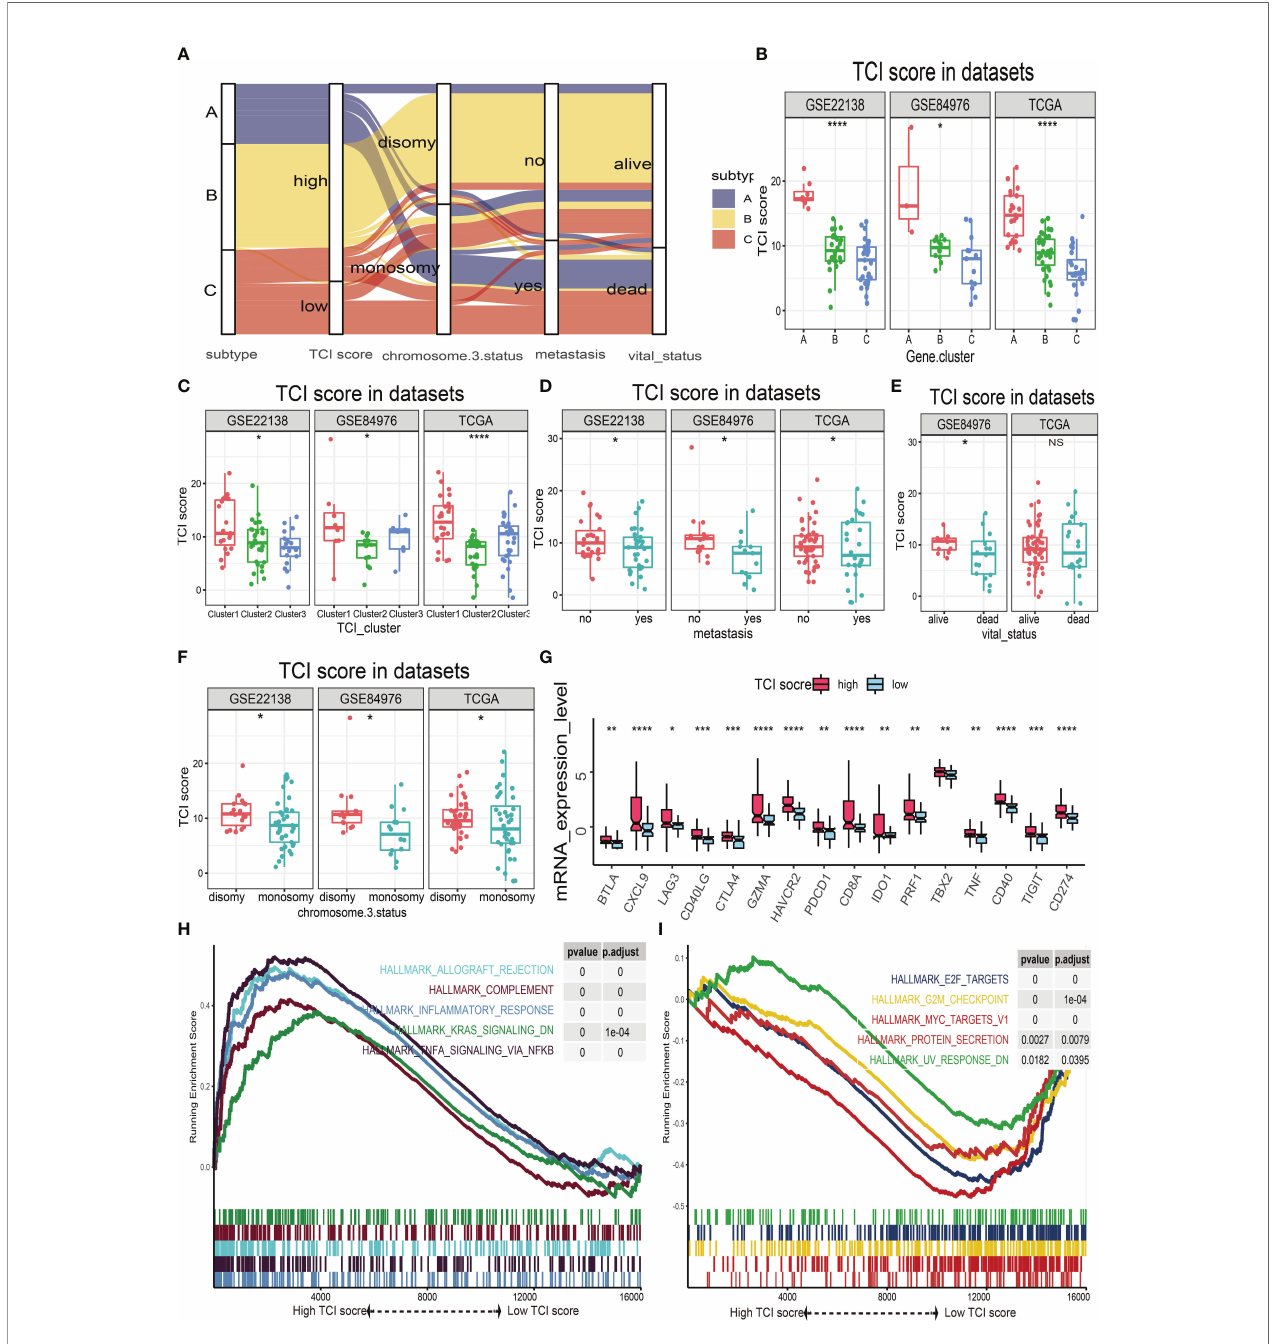
FIGURE 5 | The relationships of TIC scores with clinical parameters, molecular indicators, and biological signal pathways. (A) Alluvial plot of immune gene-related clusters with different TIC scores, chromosome 3 status, metastasis, and vital status. (B) The TIC score distribution of immune gene-related clusters. (C) The TIC score distribution of in fi ltrated immune cell subtypes. (D) The TIC score distribution of metastasis. (E) The TIC score distribution of vital status. (F) The TIC score distribution of chromosome 3 status. (G) Box plots of immune checkpoint-related genes (BTLA, CXCL9, GZMA, CD8A, TBX2, PRF1, TNF, and TIGIT) and immunological activity-related genes (BTLA, CXCL9, GZMA, CD8A, TBX2, PRF1, TNF, and TIGIT) between high-TIC score and low-TIC score groups. (H) GSEA plots of signi fi cant cancer hallmark pathways enriched in high-TIC score phenotype. (I) GSEA plots of signi fi cant cancer hallmark pathways enriched in low-TIC score phenotype. * p < 0.05; ** p < 0.01; *** p < 0.001; and **** p <